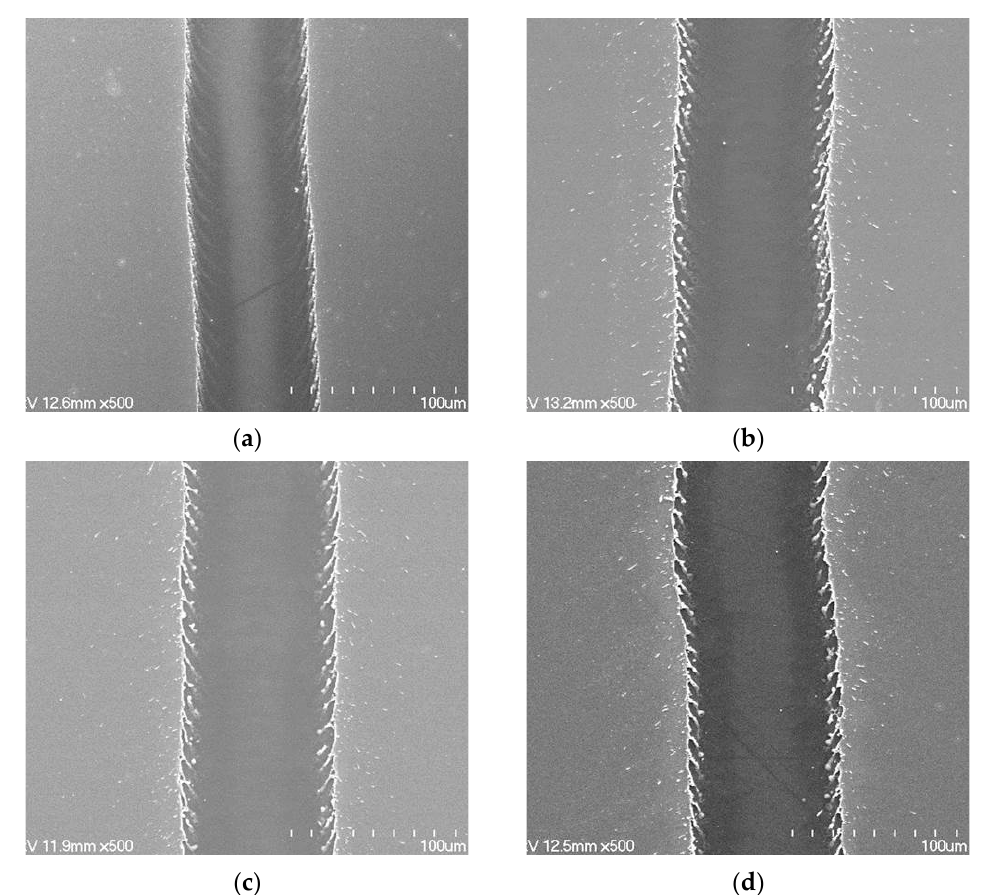
Figure 4. SEM images of laser-ablated ITO/Ag/ITO MLs with different Ag thicknesses of ( a ) 0, ( b ) 6, ( c ) 13, and ( d ) 16 nm at a scanning speed of 500 mm/s and laser pulse energy of 67 μ J.